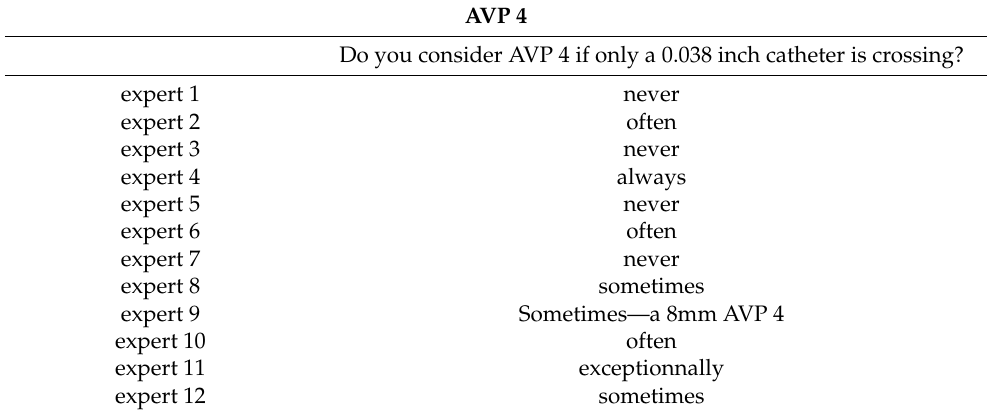
Table 9. Amplatzer Vascular Plug 4 (AVP 4) for tPVLc.